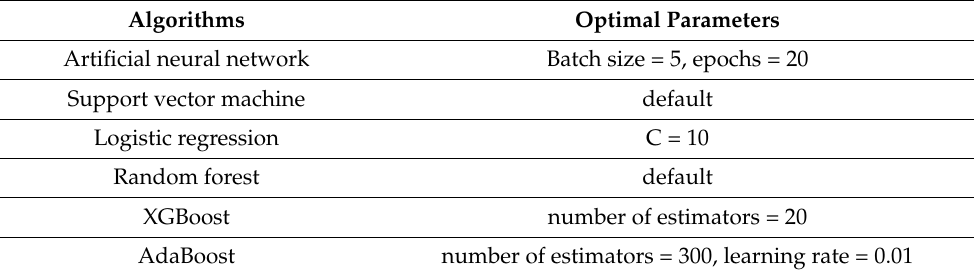
Table 4. Optimal hyperparameters used in the